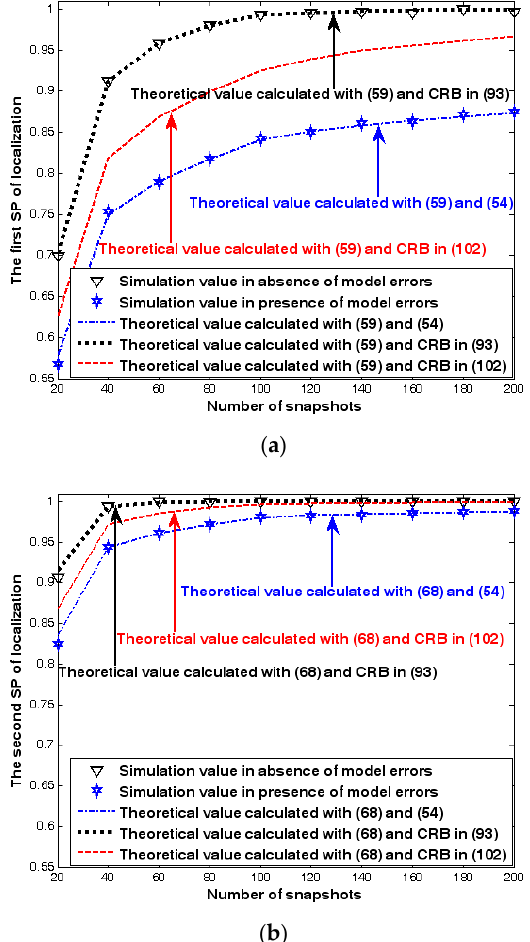
Figure 18. SP of localization as a function of number of snapshots. ( a ) The first SP of localization as a function of number of snapshots. ( b ) The second SP of localization as a function of number of